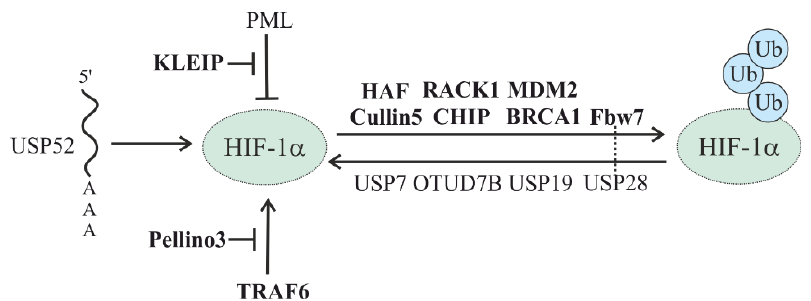
Figure 7. Involvement of E3 ligases and DUBs in the oxygen-independent regulation of HIF. E3 ligases are depicted in bold. The dotted line indicates known direct interactions between an E3 ligase and DUB.